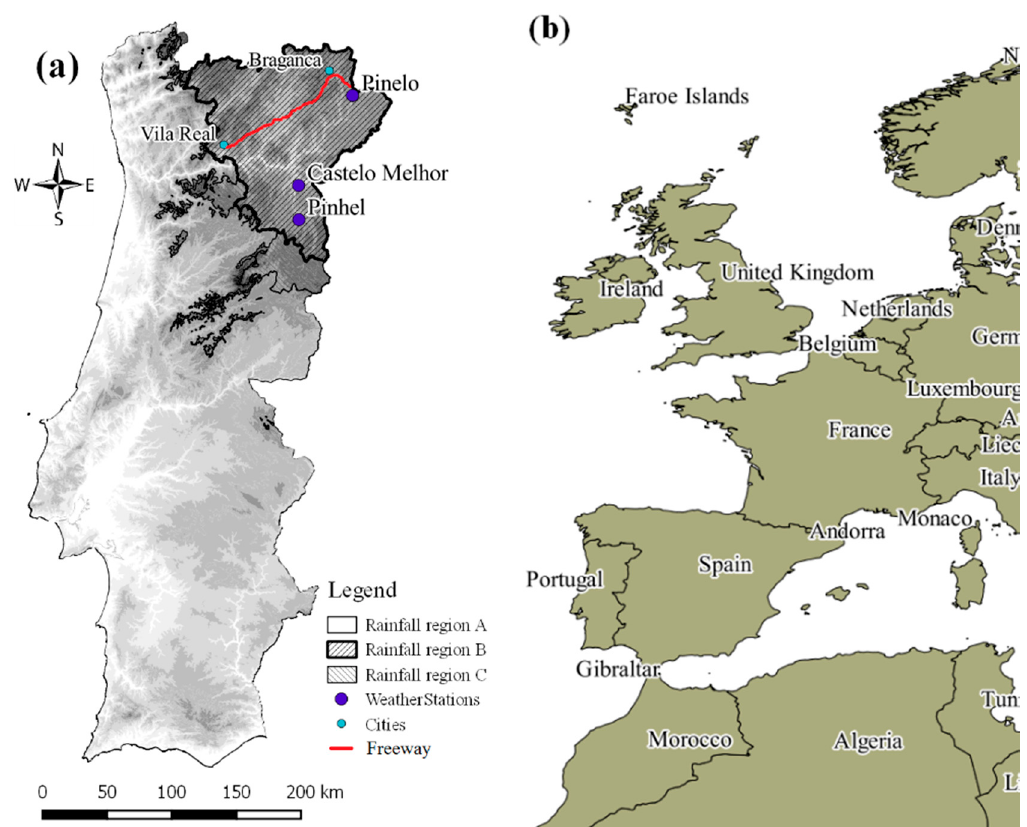
Figure 1. Location of ( a ) the highway “Auto-Estrada Transmontana” linking two Portuguese districts’ capitals (Vila Real and Bragança), three rainfall regions legally defined for Portugal by [55], three weather stations within rainfall region B and ( b ) of Portugal in western Europe.